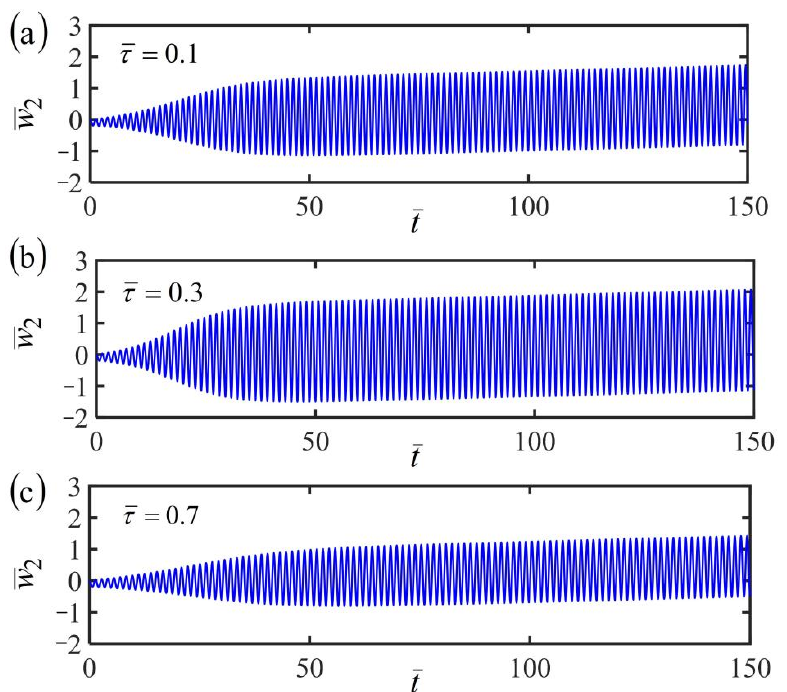
Figure 11. Variations of the displacement of the fiber-mass system with time for the case of a uniform translational frame in a linear temperature field for ( a ) finite characteristic times τ = 0.1, ( b ) τ = 0.3, and ( c ) τ = 0.7. The amplitude first increases and then decreases obviously with the increasing characteristic time.